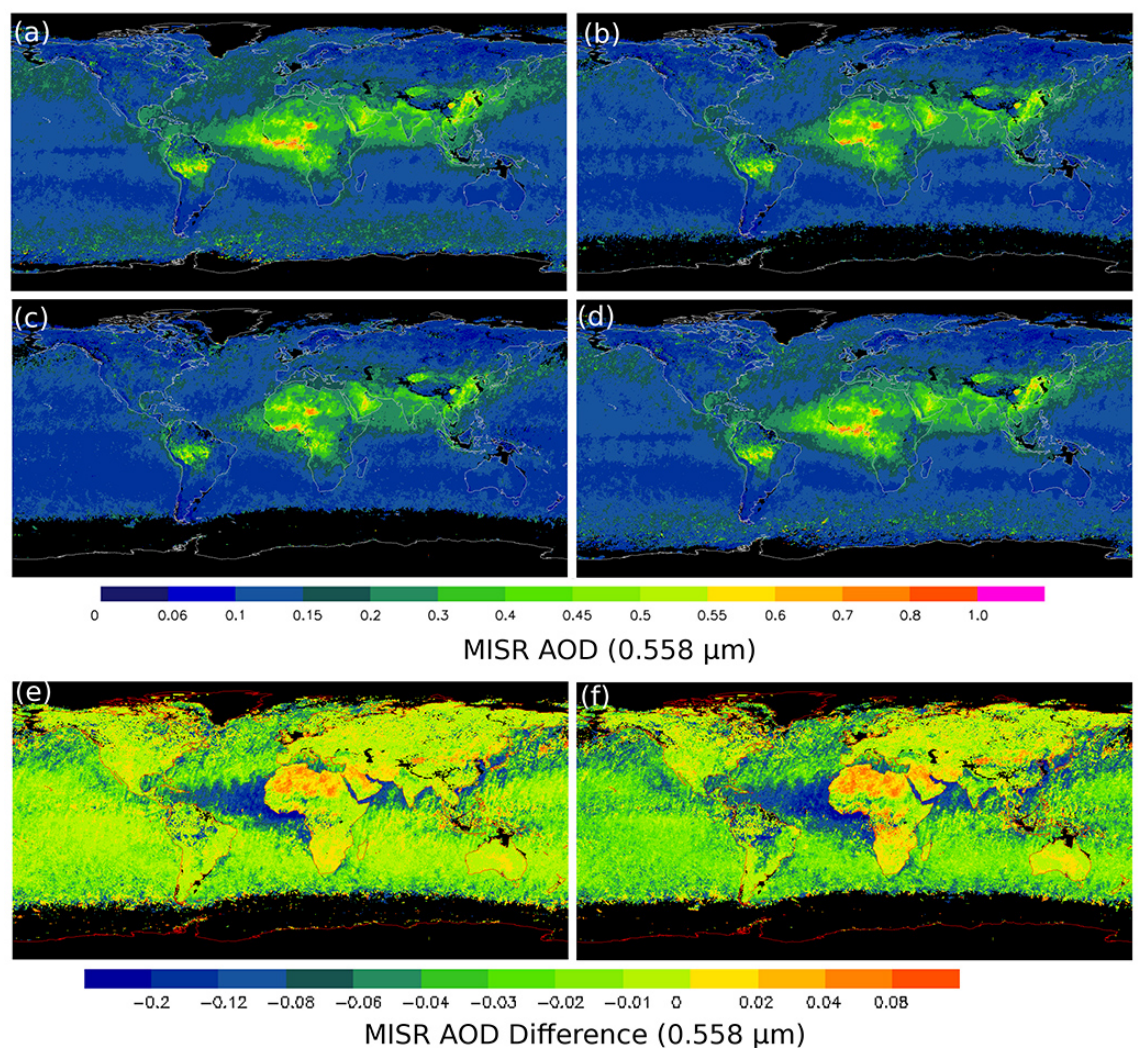
Figure 3. Spatial distribution of MISR AOD for the 2007 data set using the half-degree (lat/lon) gridded level 3 MISR AOD data. (a) for self- QAed MISR data, (b) for MISR data after applying the F cc > 20% and F cirrus_free = 100% cloud filters, (c) for MISR data after applying the F cc > 80% and F cirrus_free = 100% cloud filters, (d) for MISR data that passed the thin cirrus cloud filter ( F cirrus_free = 100%), (e) AOD plot of (b) minus (a) , and (f) same as (e) but for (c) minus (a) . Color contours progressing from cold to warm represent increasing AOD values with the black color representing regions with no